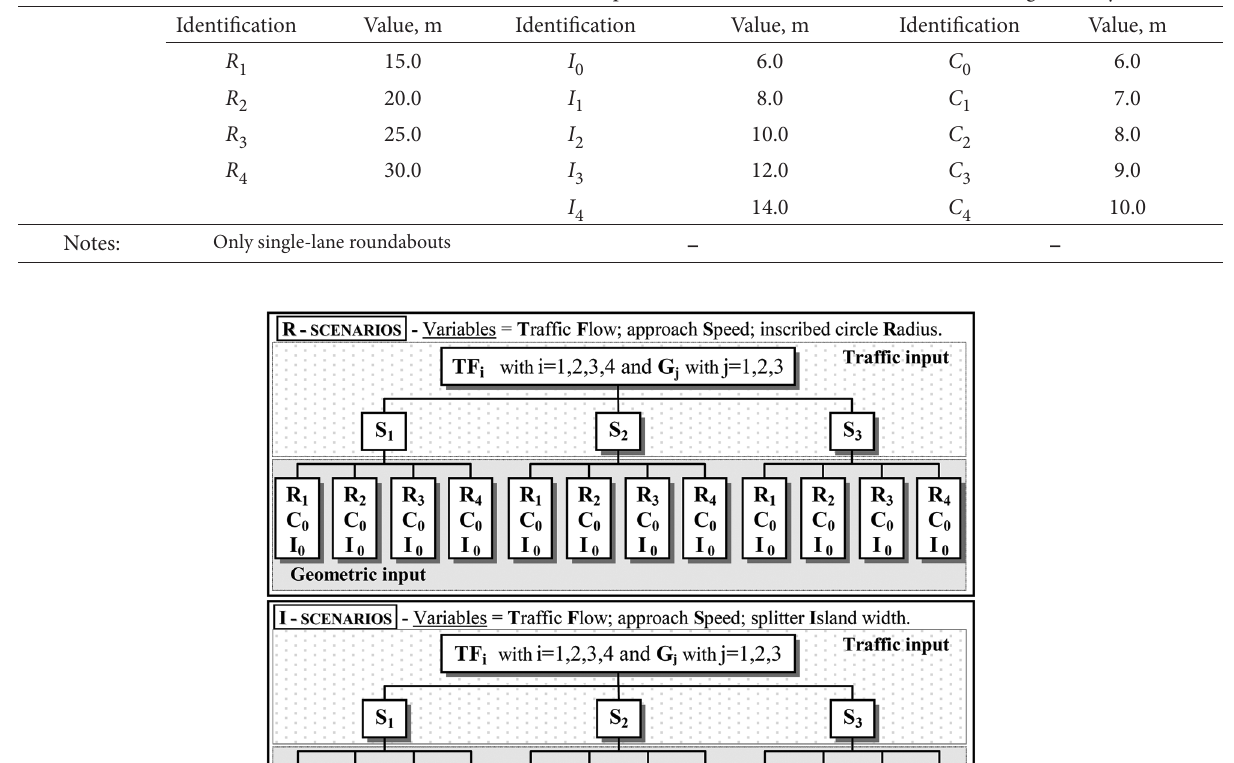
Table 2. Summary of the imposed values for the geometric features of the scenarios Parameters